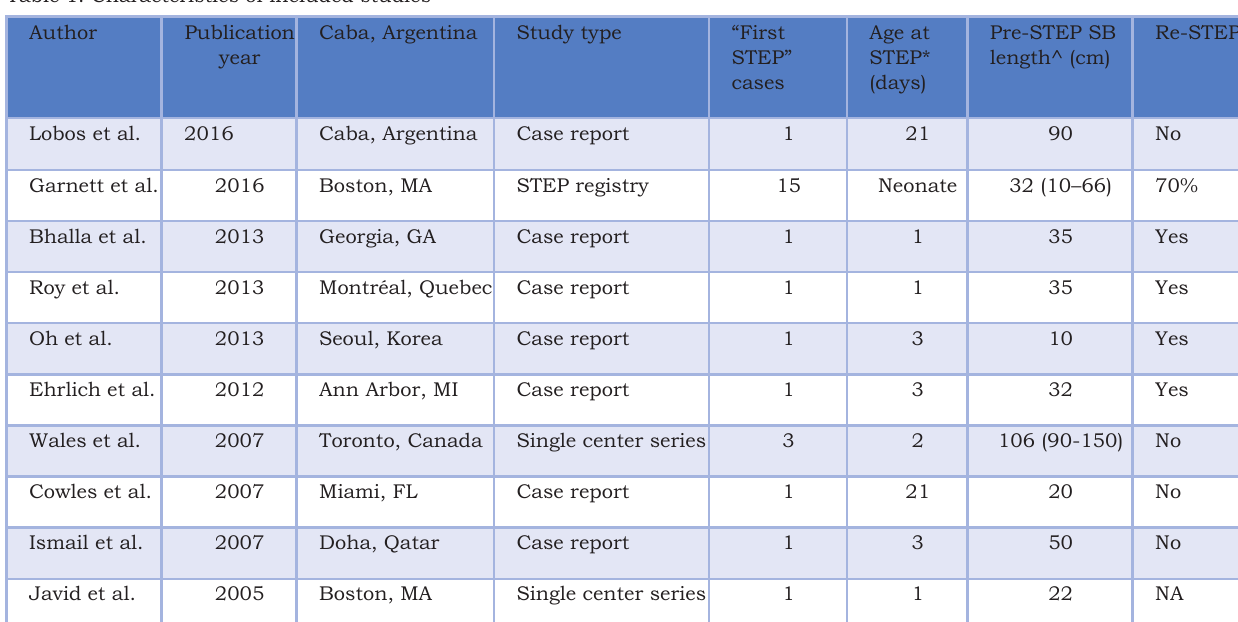
Figure 1: PRISMA flow diagram of study selection Table 1: Characteristics of included